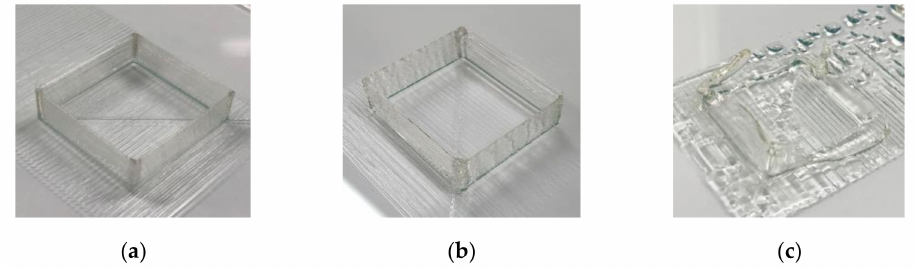
Figure 7. Printed specimens according to the relative humidity of the chamber: ( a ) 20%, ( b ) 40%, ( c )